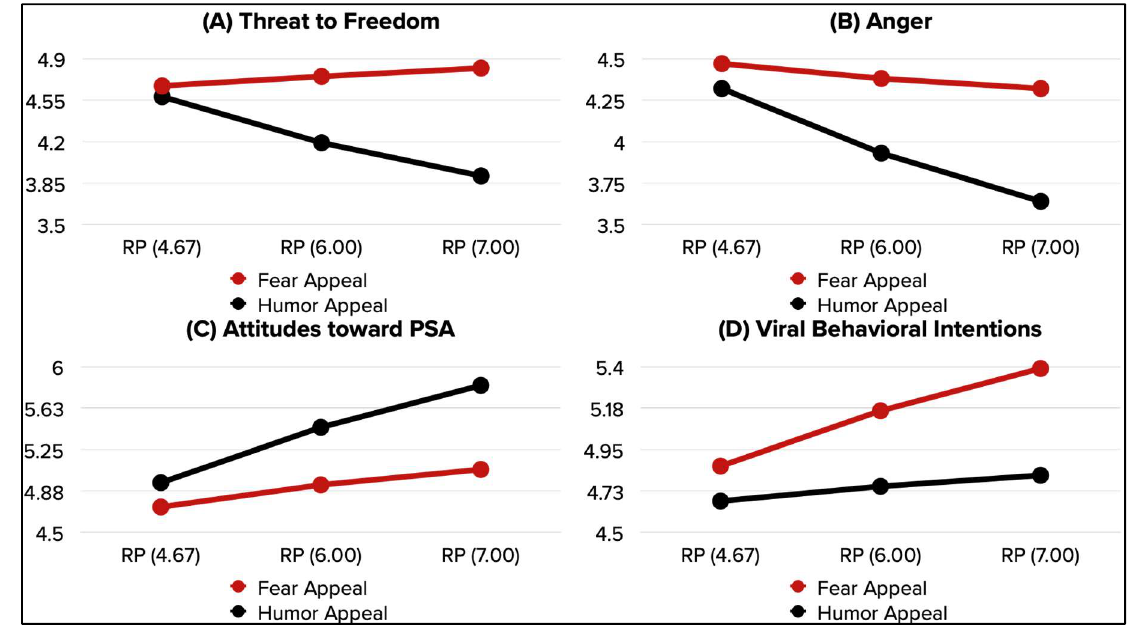
Figure 4. Moderating effect of risk perception on T2F, Anger, A PSA , and VBI.